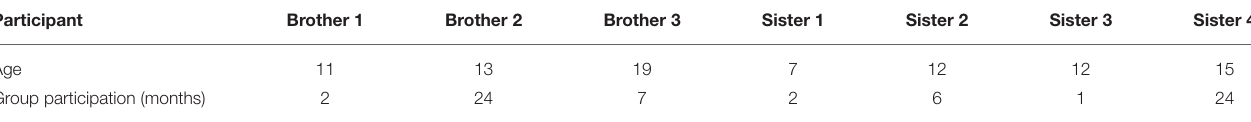
TABLE 2 | Characteristics of the study